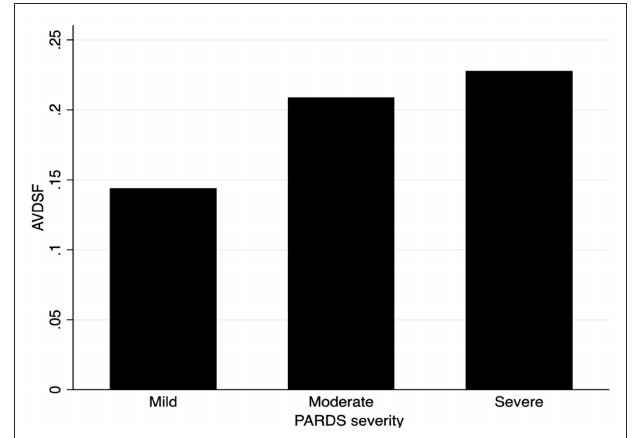
FIGURE 2 | AVDSF across PARDS severity groups. NB: This figure was generated using mean AVDSF of 7 days. AVDSF, Alveolar dead space fraction; PARDS, Pediatric Acute Respiratory Distress